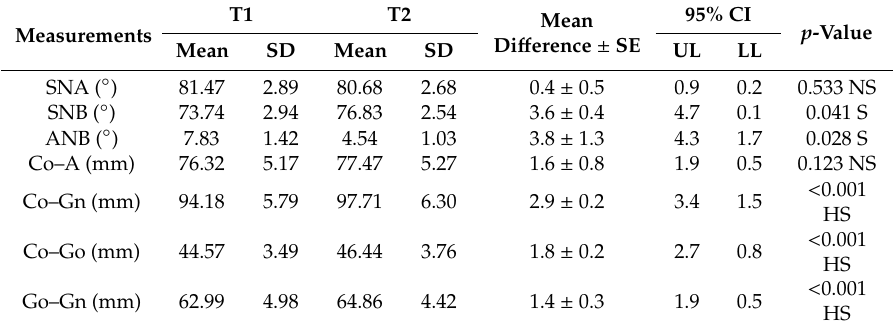
Table 8. Comparison of lateral cephalometric skeletal measurements before and after twin block therapy in laser group using paired t -test.